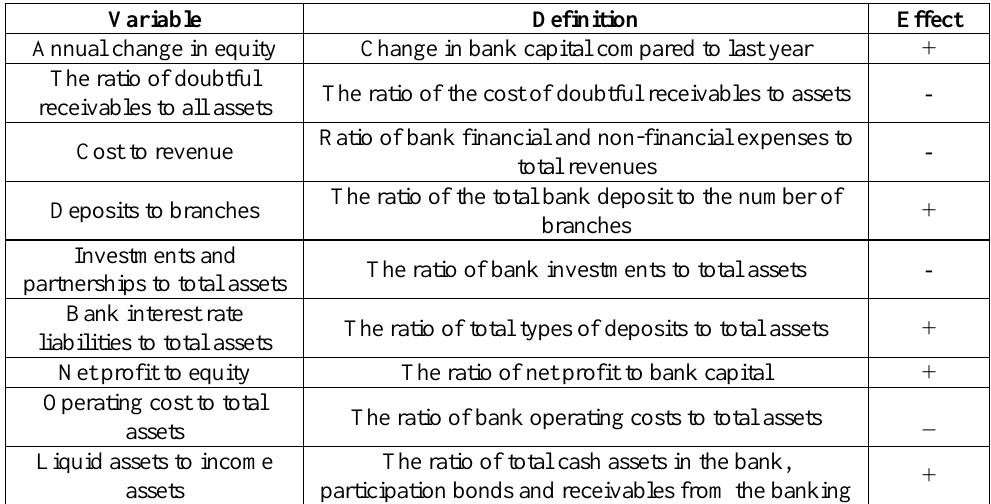
Table 1. Leading variables in financial crisis